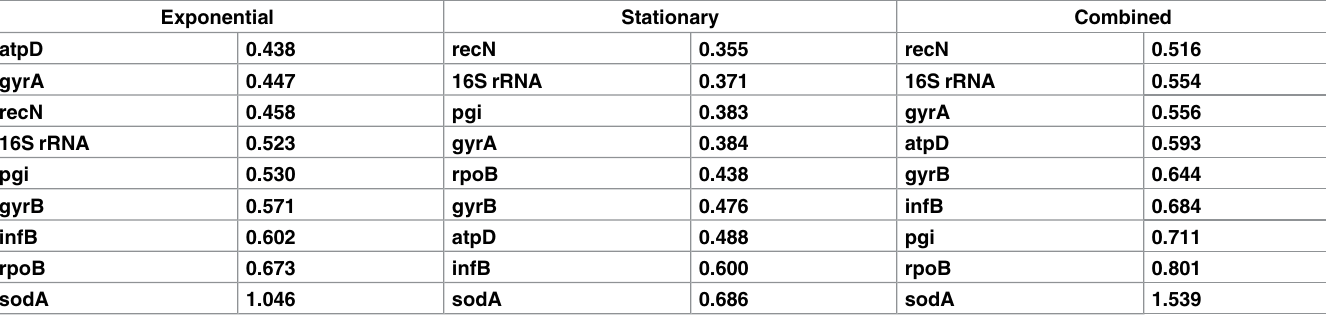
Table 3. Gene expressionstability rankings for different growth phase in A . paragallinarum serovarB analyzed by geNorm. Exponential